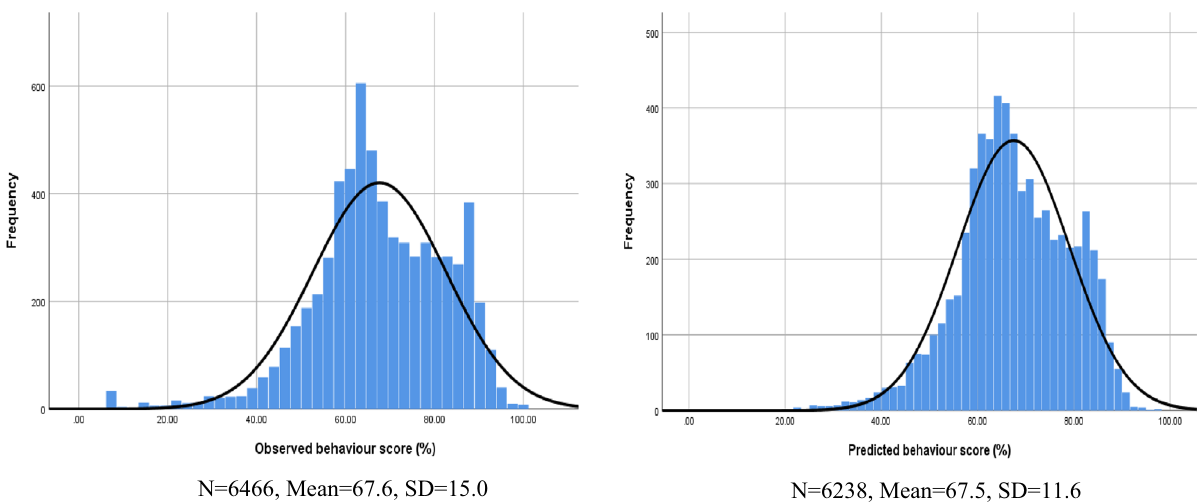
Figure 3. Distribution of observed and predicted behaviour scores